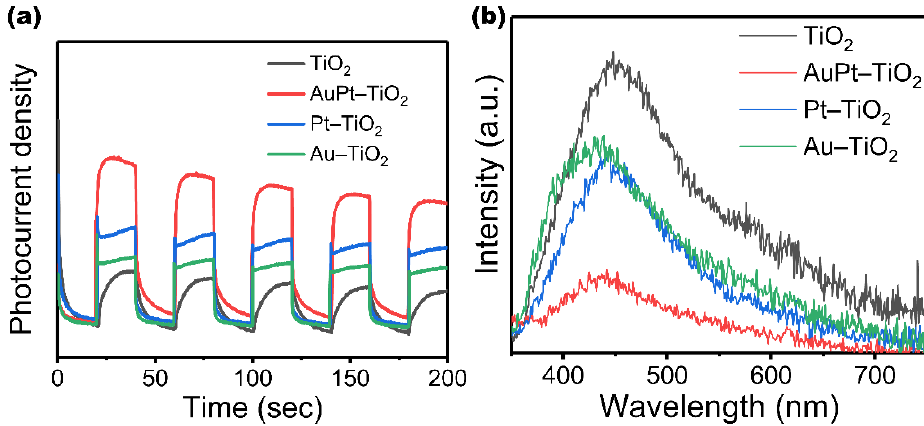
Figure 6. ( a ) Transient photocurrent spectra and ( b ) PL spectra of TiO 2 , AuPt – TiO 2 , Pt – TiO 2 and Au – TiO 2 .